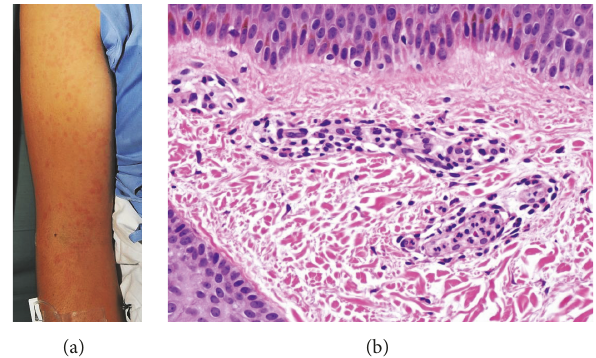
Figure 2: (a) Salmon-pink rash at forearm. (b) Normal epidermis with no necrotic keratinocytes. Superficial perivascular cells infiltration with neutrophils. No evidence of vasculitis (H&E, ×